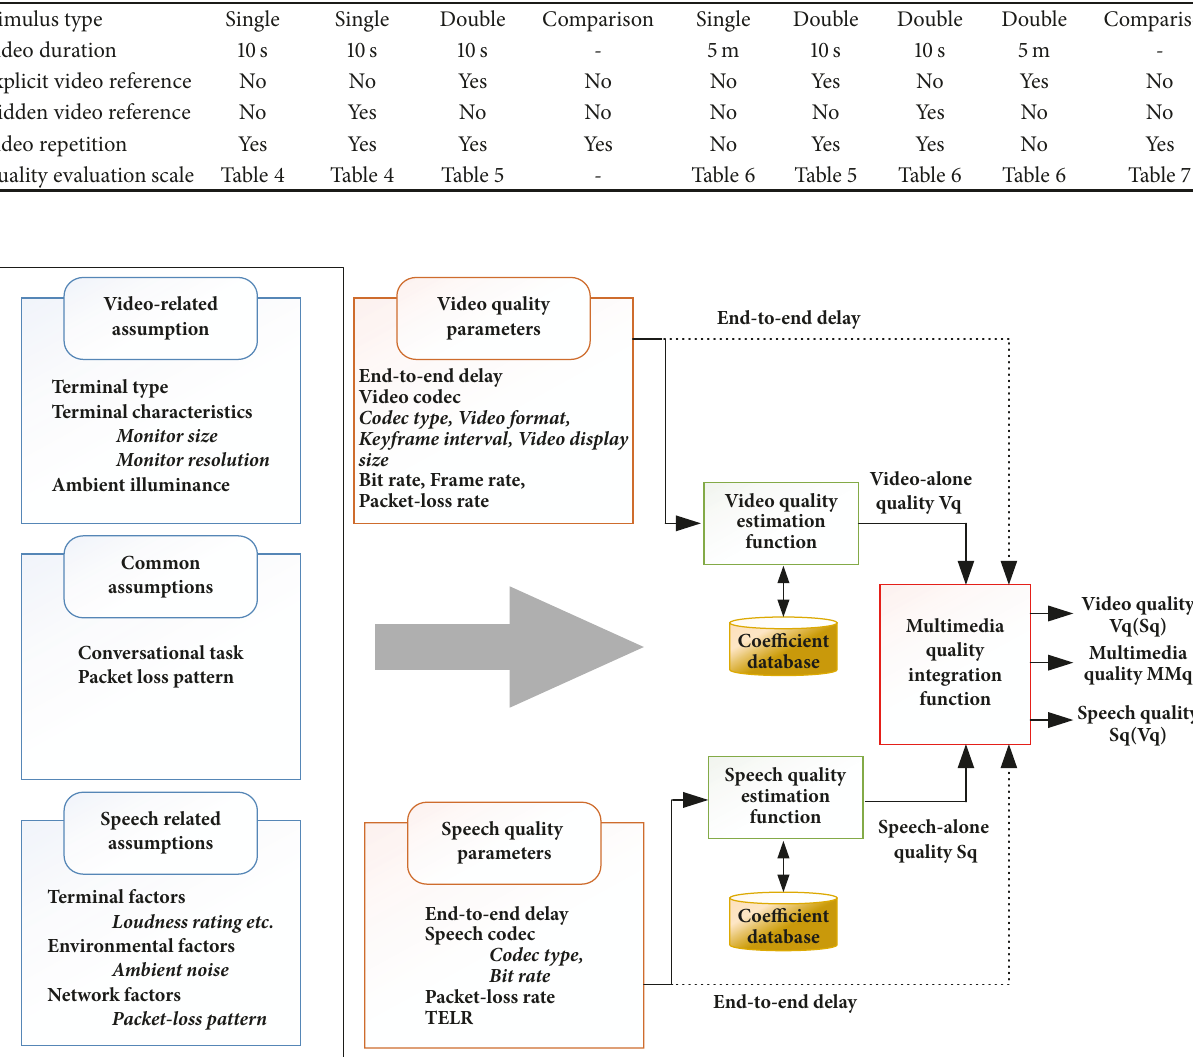
Figure 17: G.1070 model